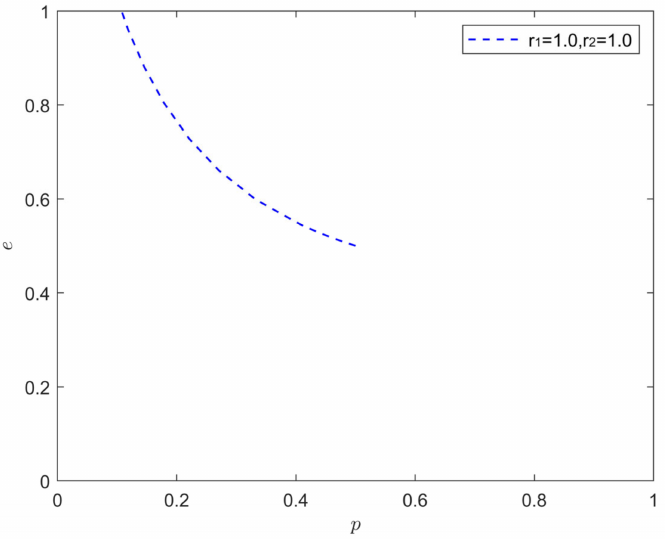
Figure 1. The development of the game’s strategy in a (rational, rational) condition.